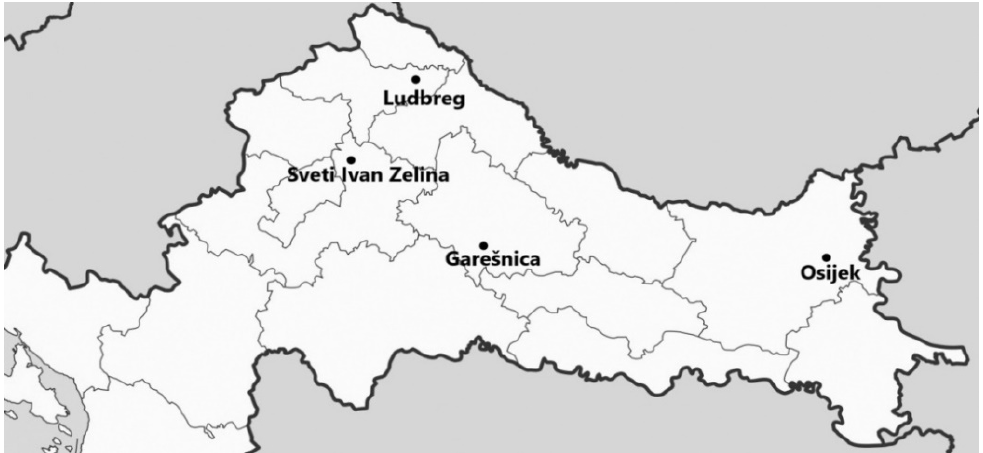
Figure 1. Sampling sites of H. axyridis in Croatia.